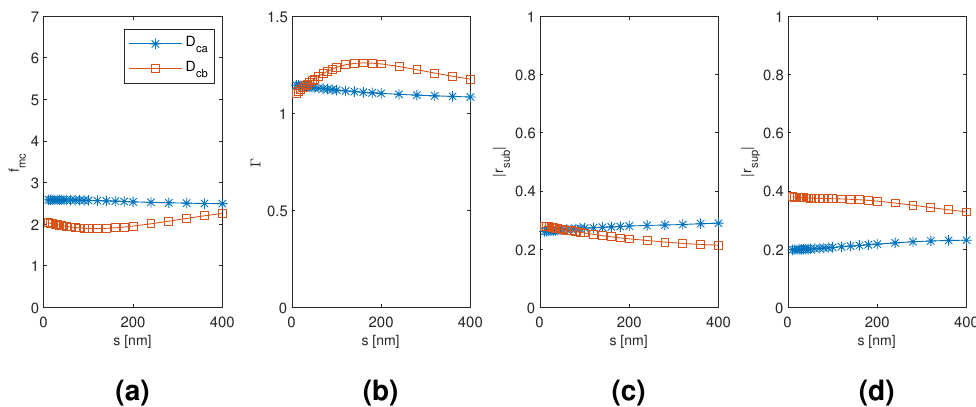
Figure 14. The results for the coated dimer D ca and D cb mode as a function of the separation of the nanowires with the diameter of the nanowires and the coating thickness corresponding to the point of modal cost function minimum for each mode (as listed in Table 2). ( a ) modal cost function value; ( b ) modal confinement factor; ( c ) substrate modal reflection coefficient magnitude; ( d ) superstrate modal reflection coefficient magnitude.